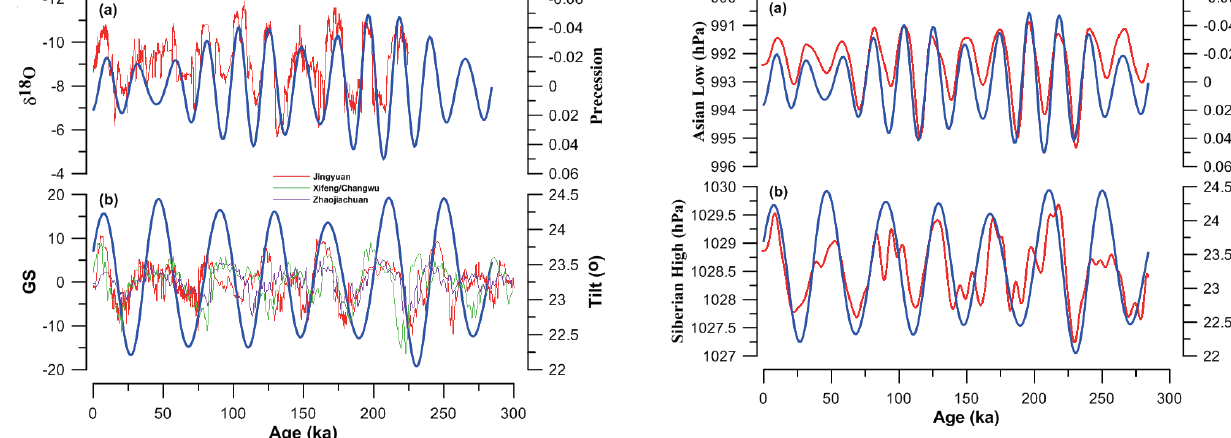
Fig. 2. Proxy records of East Asian monsoon evolution. (a) The absolute-dated stalagmite δ 18 O record from Sanbao and Hulu caves in Central China during the past 224ka (red). The parameter of precession is plotted for comparison (blue). (b) Three grain size records of Chinese loess from Jingyuan (red)/Xifeng-Changwu (green)/Zhaojiachuan (purple) sections covering the past 300ka, plotted on arbitrary scale. The 100-ka component (greater than 67ka) has been filtered out. The parameter of obliquity is plotted for comparison (blue).